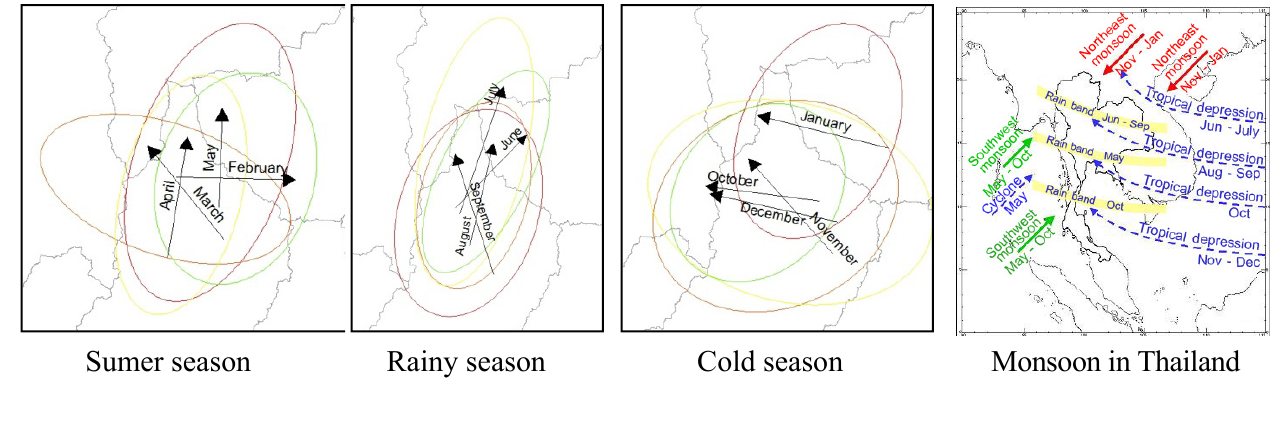
Sumer season Rainy season Cold season Monsoon in